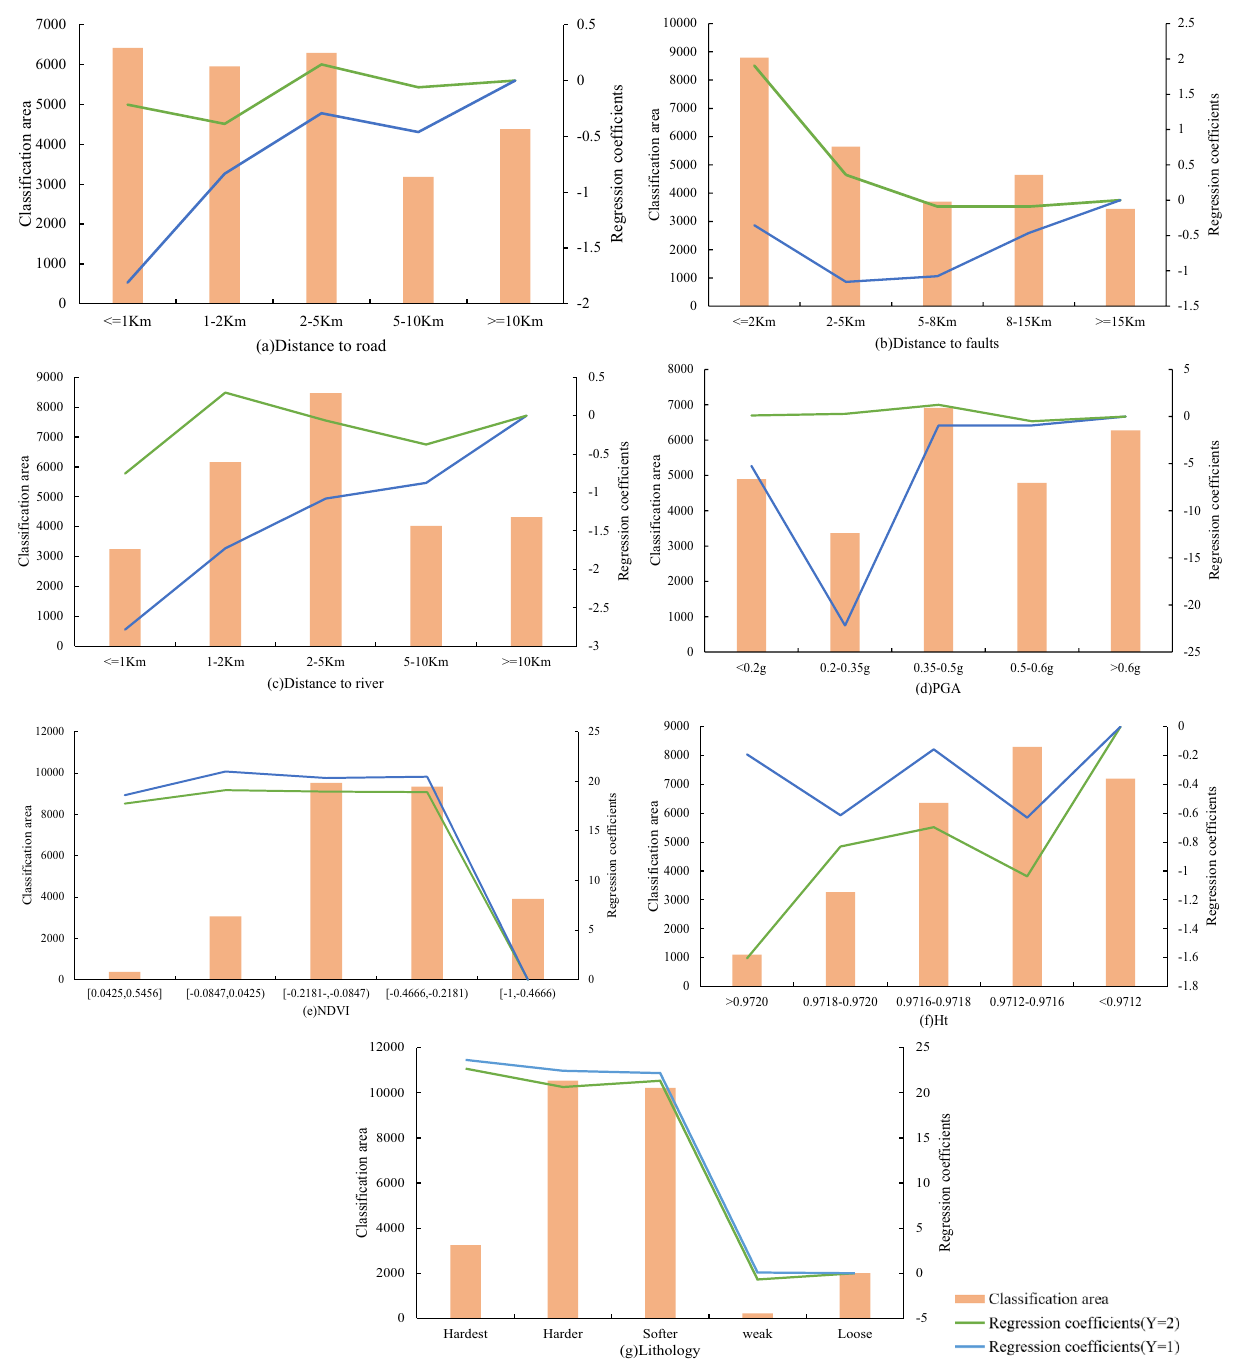
Figure 6. MLR coefficients under the grading of various conditioning factors (Name of software: Office 2019).